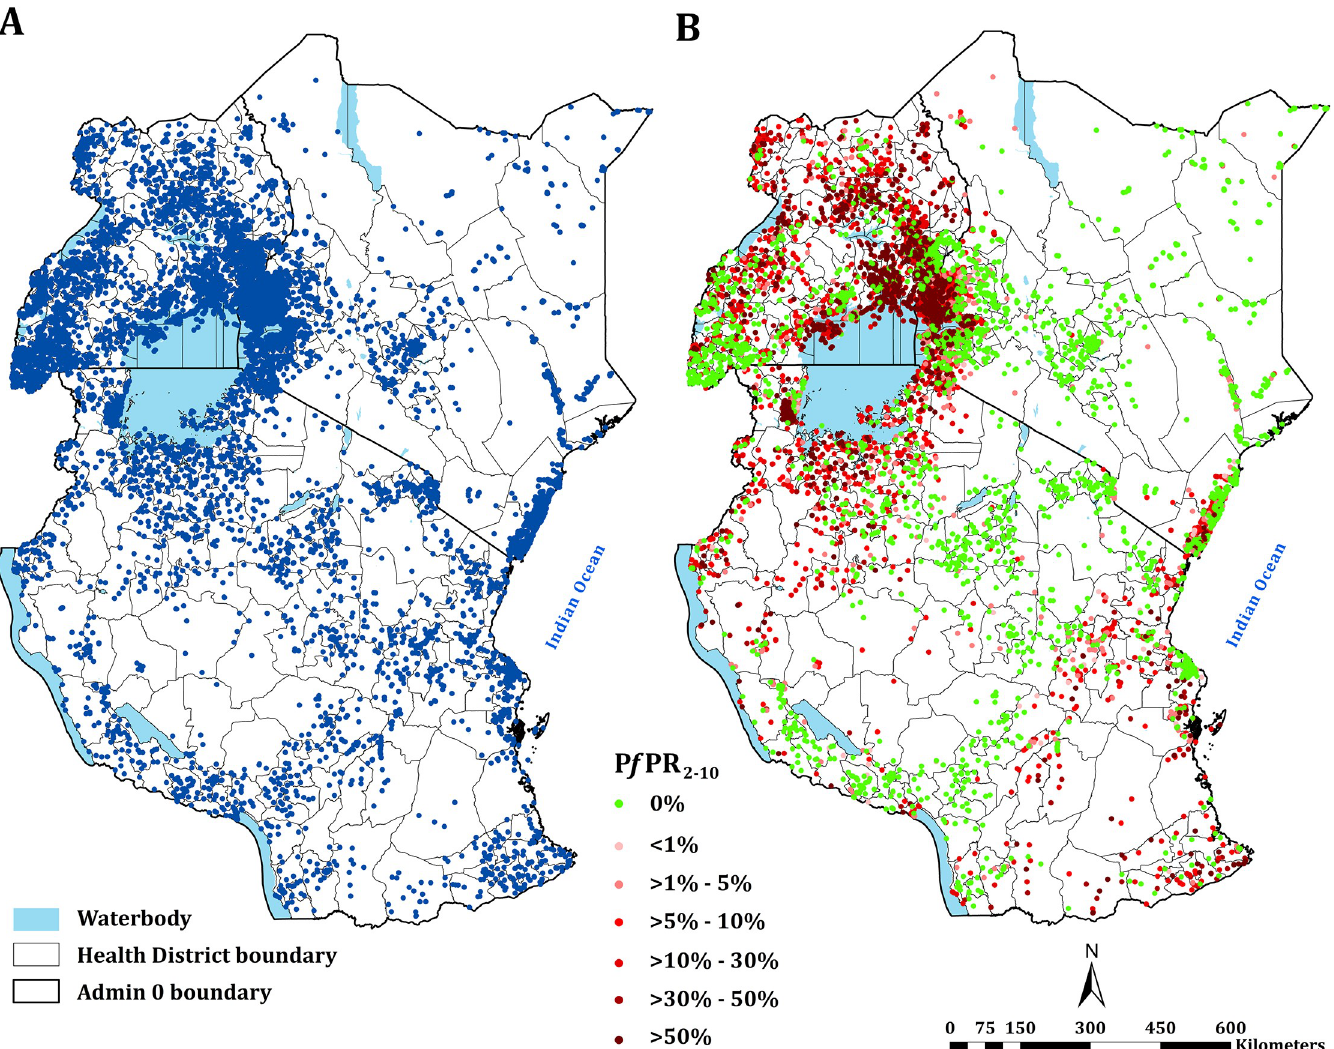
Fig 1. Assembled parasite rate surveys. (A) Distribution of all assembled survey data ( n = 18940) between 2010–2020; (B) the distribution of age-corrected and microscopy-standard parasite prevalence ( Pf PR 2-10 ) estimates among samples � 10 individuals with the highest values on top when multiple surveys conducted at the same location. Base shapefiles used in all figures downloaded from: Kenya– https://data.humdata.org/dataset/ken-administrative-boundaries; Uganda– https://data. humdata.org/dataset/uganda-administrative-boundaries-admin-1-admin-3 and Tanzania–https://data.humdata.org/dataset/tanzania-administrative-boundaries-level- 1-to-3-regions-districts-and-wards-with-2012-population https://gadm.org/.